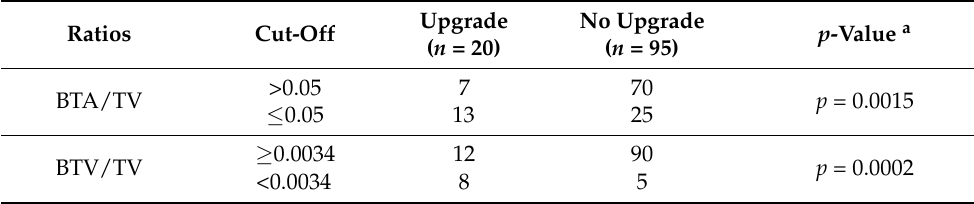
Table 2. Correlation among ratios between bioptic and surgical tumor volumes and GS (Gleason Score)